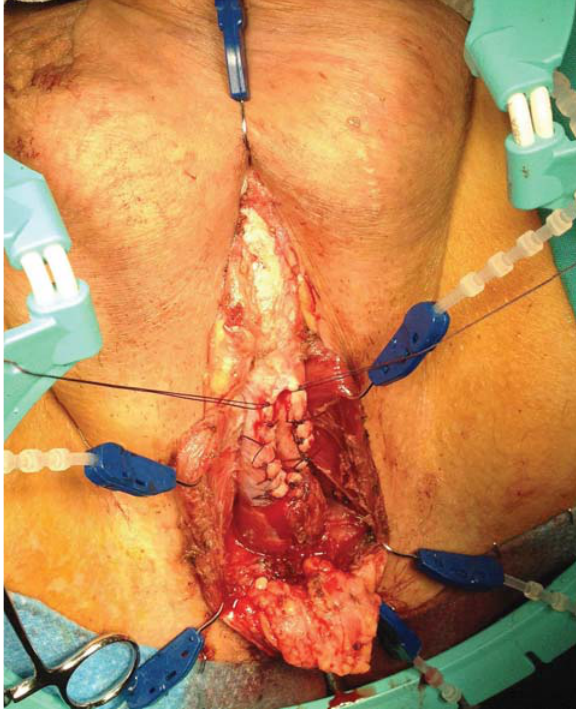
Figure 1 - Urethrotomy and hemostatic